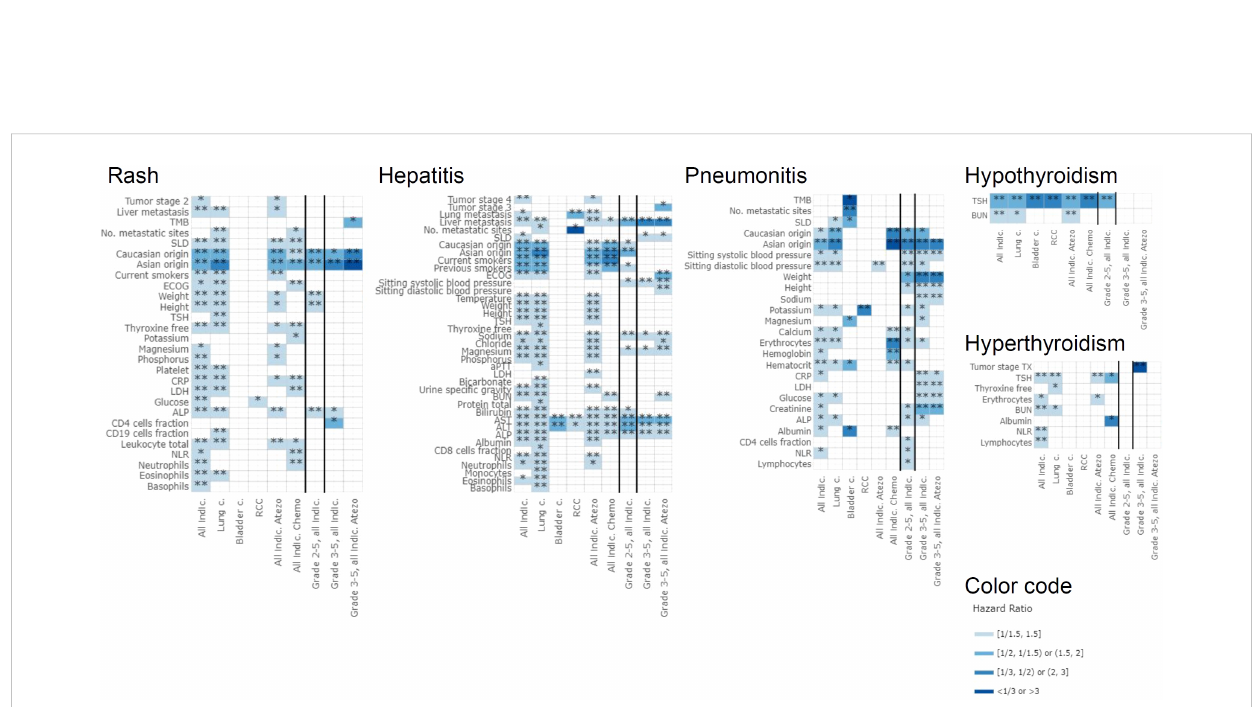
FIGURE 2 Effect estimates from the IPD meta-analysis for the baseline risk factors (rows) with an FDR-adjusted p-value<0.1 in at least one of the analyses (columns). The color refers to the absolute hazard ratio size representing the strength of association. The symbol refers to the level of signi fi cance (FDR p-value<0.1: *, FDR p-value<0.05: **). The following different analyses were performed: “ All indic. ” (across different indications and arms), “ Lung c. ” (only lung cancer studies including all arms), “ Bladder c. ” (only UC studies including all arms), “ RCC ” (only RCC studies including all arms), “ All indic. Atezo ” (across different indications but only atezolizumab arms), “ All indic. Chemo ” (across different indications but only standard of care arms), “ Grade 2-5, all indic. ” (across different indications and arms, only grade 2+ irAEs), “ Grade 3-5, all indic. ” (across different indications and arms, only grade 3+ irAEs), “ Grade 3-5, all indic. Atezo ” (across different indications, only atezolizumab arms and grade 3+ irAEs). Abbreviations of risk factors: ALP, Alkaline Phosphatase; ALT, Alanine Aminotransferase; aPTT, activated Partial Thromboplastin Time; AST, Aspartate Aminotransferase; BUN, Blood Urea Nitrogen; CRP, C-Reactive Protein; ECOG, Eastern Cooperative Oncology Group performance status; LDH, Lactate Dehydrogenase; NLR, Neutrophil-Lymphocyte Ratio; SLD, Sum of the Longest Diameters; TMB, Tumor Mutational Burden; TSH, Thyroid Stimulating Hormone.